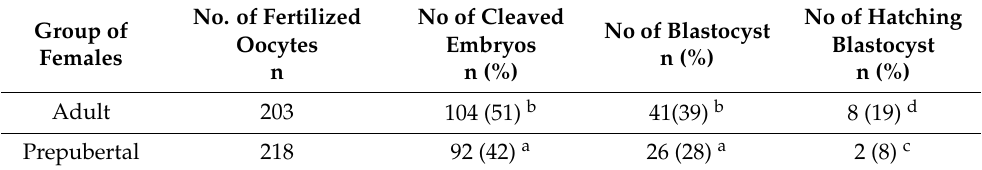
a,b values with different superscripts within the same column differ significantly ( p < 0.05). c,d values with different super- scripts within the same column differ significantly ( p < 0.001). Table 3. Results of in vitro fertilization (IVF) of oocytes obtained from prepubertal and adult domes- Table 4. Number of blastomeres (mean, SD) in blastocyst from adult and prepubertal domestic cats and its allocation to trophoblast and inner cell mass. tic cats.